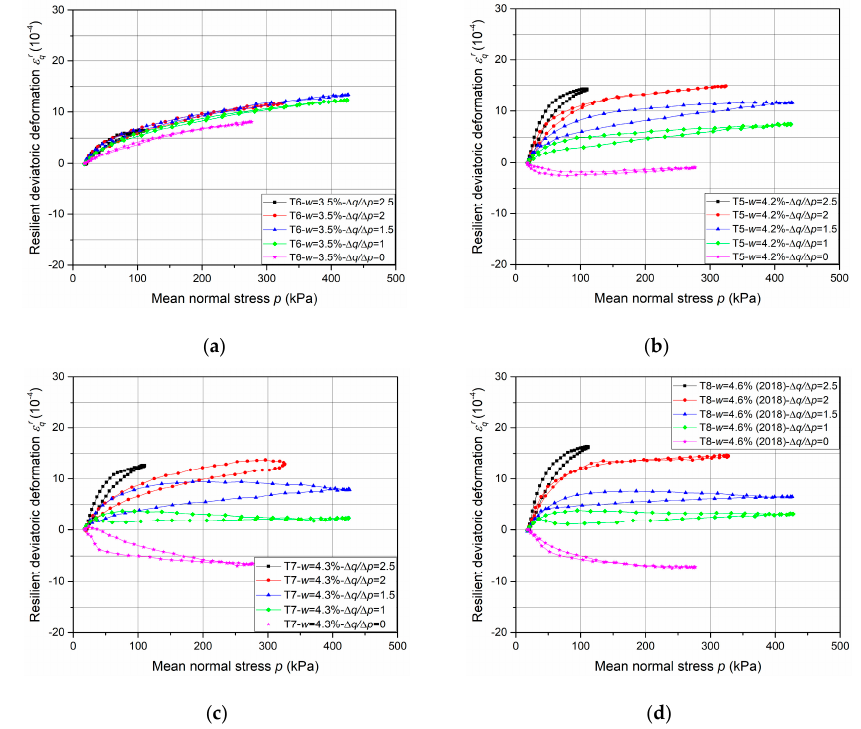
Figure 16. Resilient deviatoric deformation ε qr at different water contents: ( a ) T6- w = 3.5%; ( b ) T5- w = 4.2%; ( c ) T7- w = 4.3%; ( d ) T8- w = 4.6%.